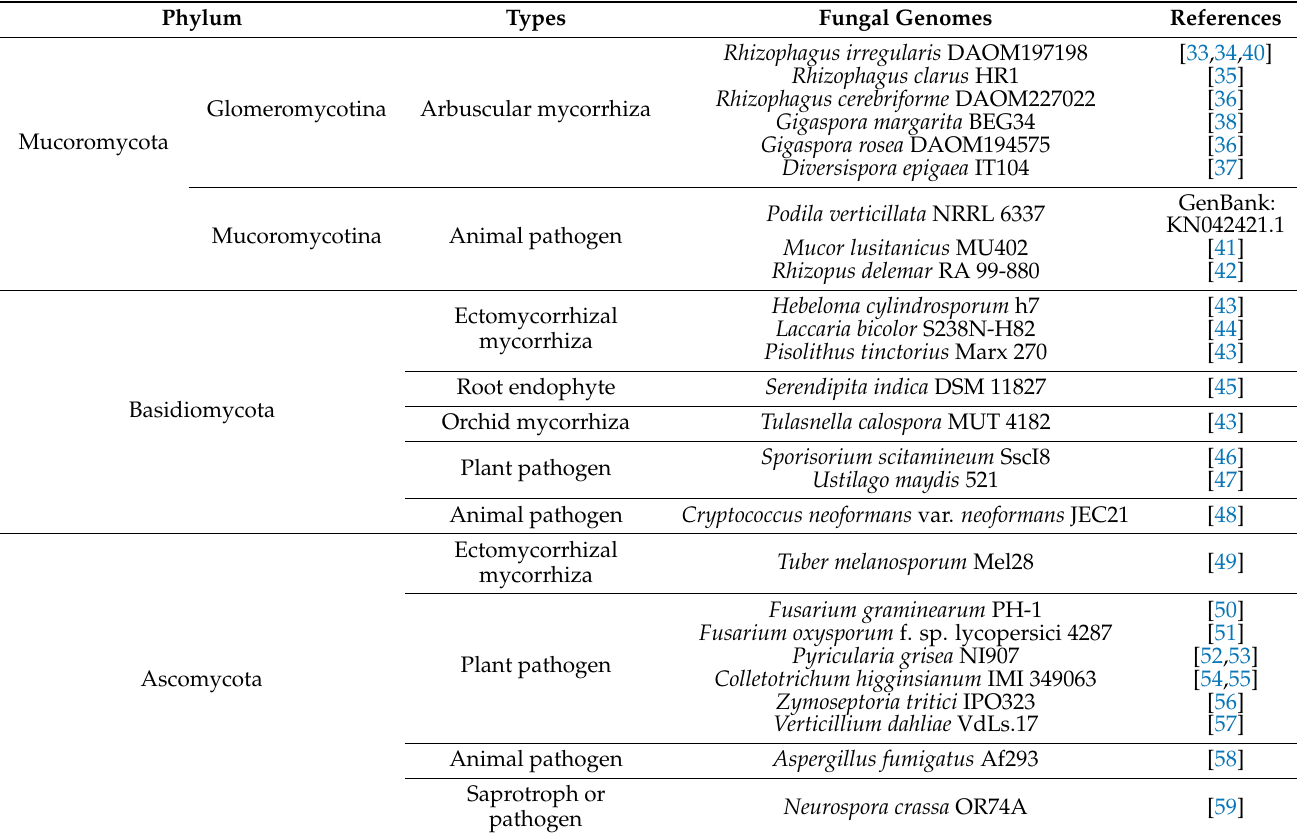
Table 1. Fungal genomes used in this